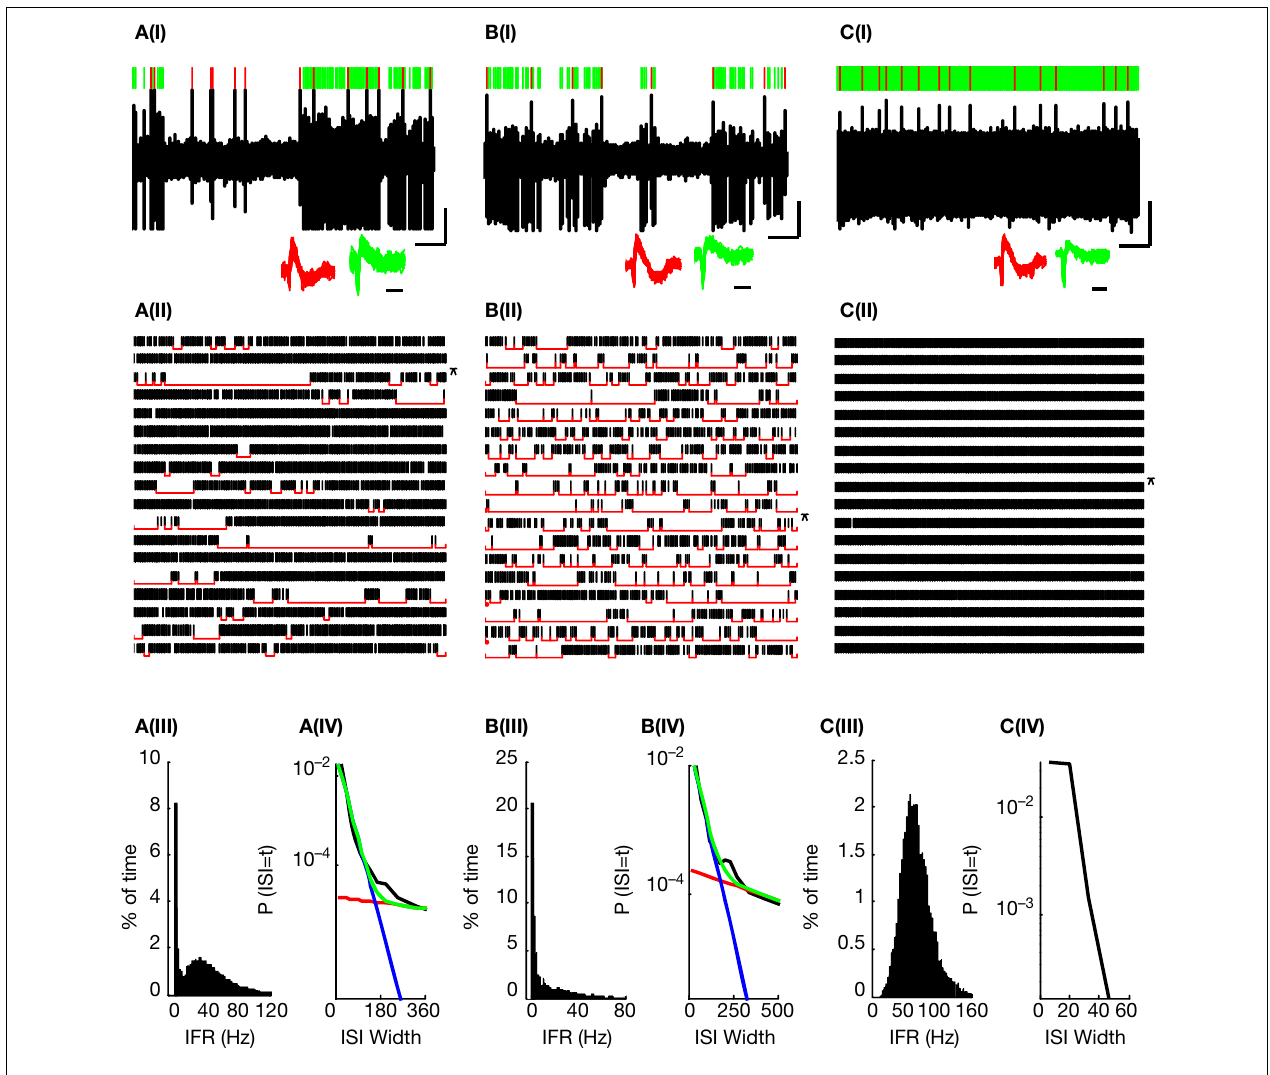
Continuous raster plot (each row is of 10 s). Raw trace in (I) is indicated by an asterix. Red lines indicate the identifi ed pauses. (III) Distribution of the SS instantaneous fi ring rate (IFR), bin size = 1 Hz. (IV) ISI distribution of PPCs (black line) was well fi t (green) as the sum of two exponential distributions presumably representing regular ISIs (blue) and pauses (red). For the CFPC, the fi tting routine converged to a solution where both exponents were